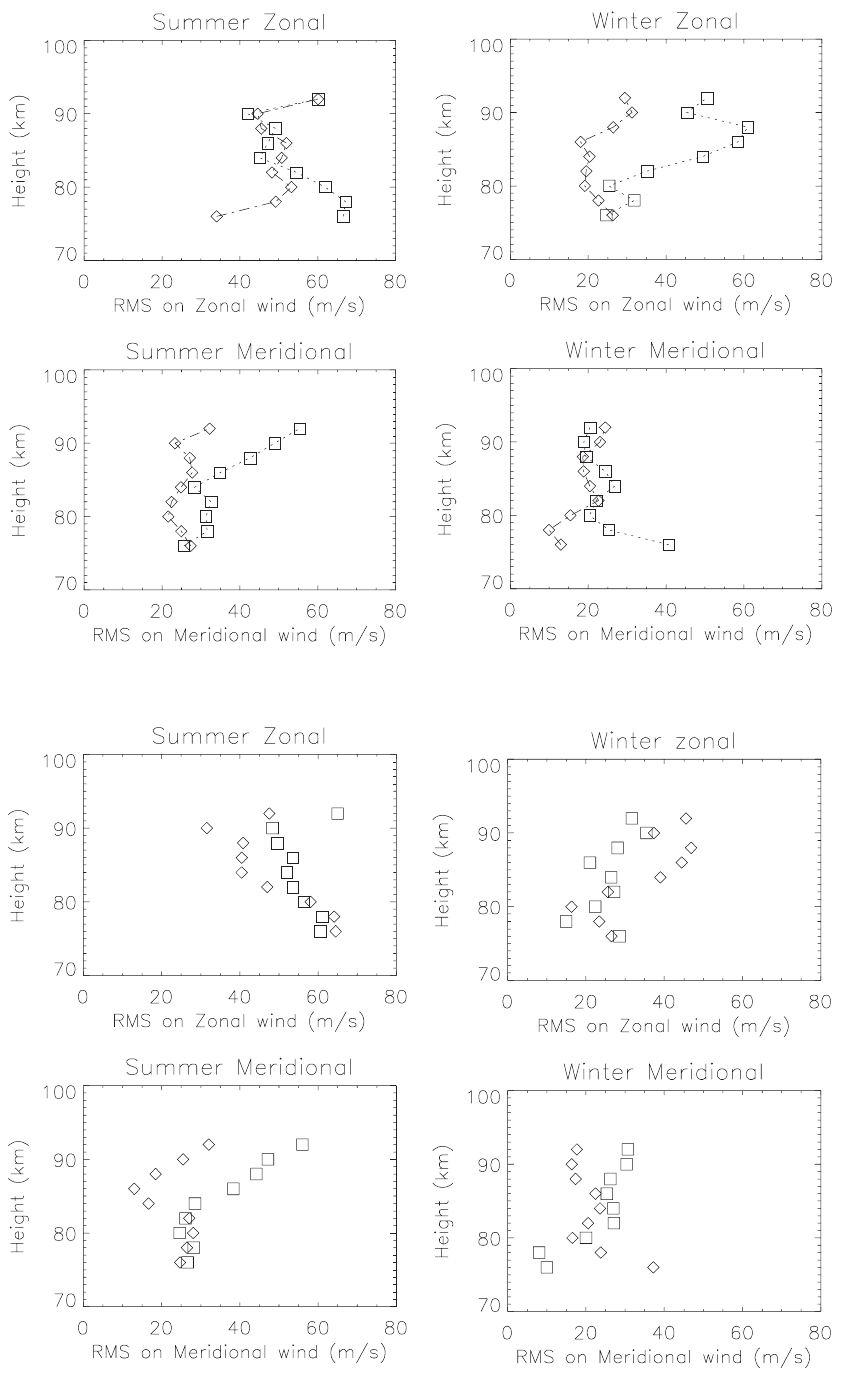
Fig. 8. RMS di(cid:128)erences between data obtained during overpasses less than 250 km from the radar site (diamonds) and data corresponding to overpasses which were more than 250 km from the radar site (squares)